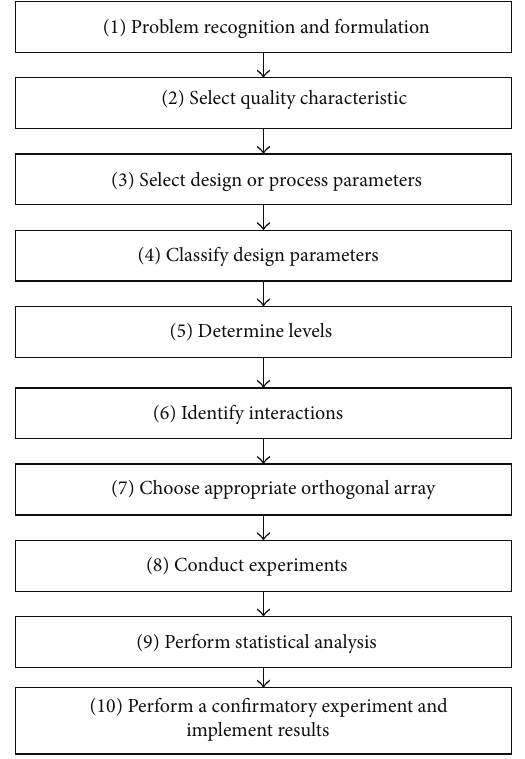
Figure 1: Taguchi method algorithm [16].